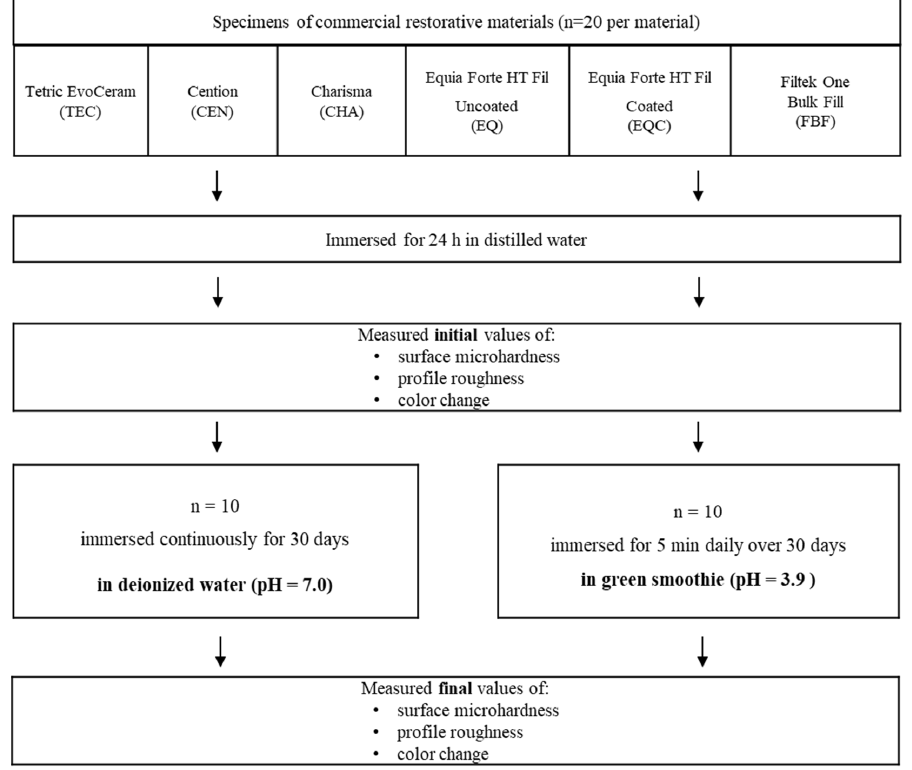
Figure 1. Flowchart of the experimental protocol.